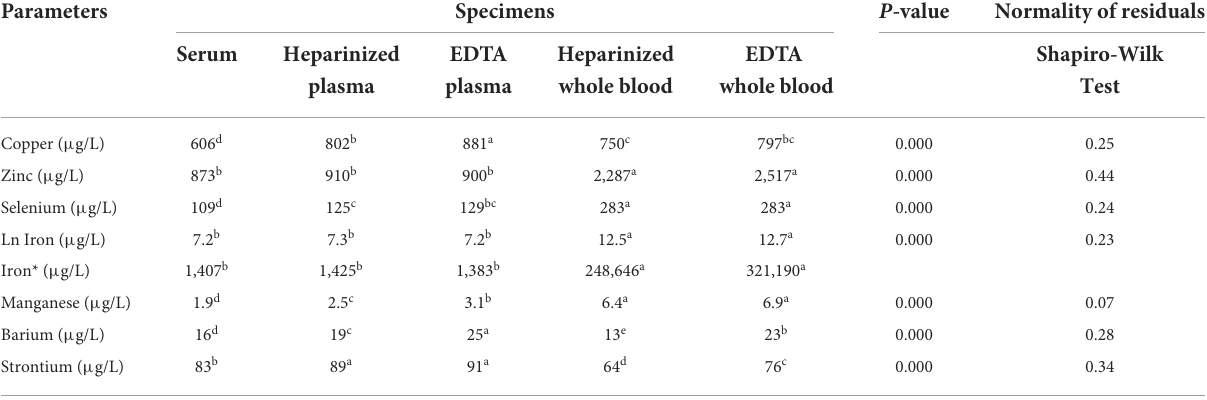
TABLE 2 Summary of the linear mixed model analysis for essential and accidental trace element concentrations in different blood specimens of dairy cows ( n = 32). Parameters